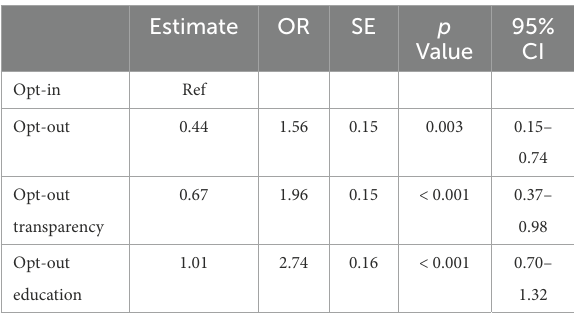
TABLE 4 Results of the binary logistic regression analysis.